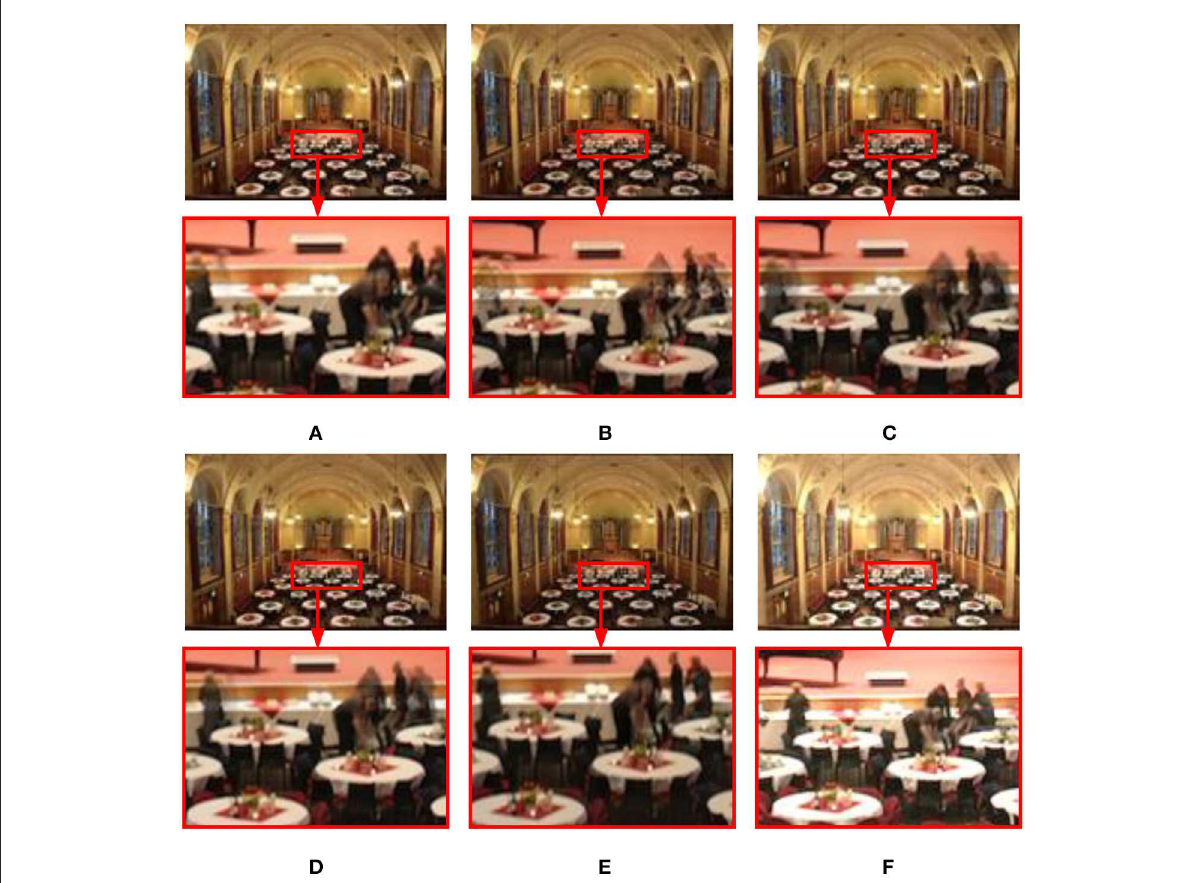
FIGURE9 Fusion results of different methods on the dynamic “Llandudno” image sequence. (A) Hayat and Imran (2019); (B) Mertens et al. (2007); (C) Li and Kang (2012); (D) Liu and Wang (2015); (E) Lee et al. (2018); (F) the proposed method in this